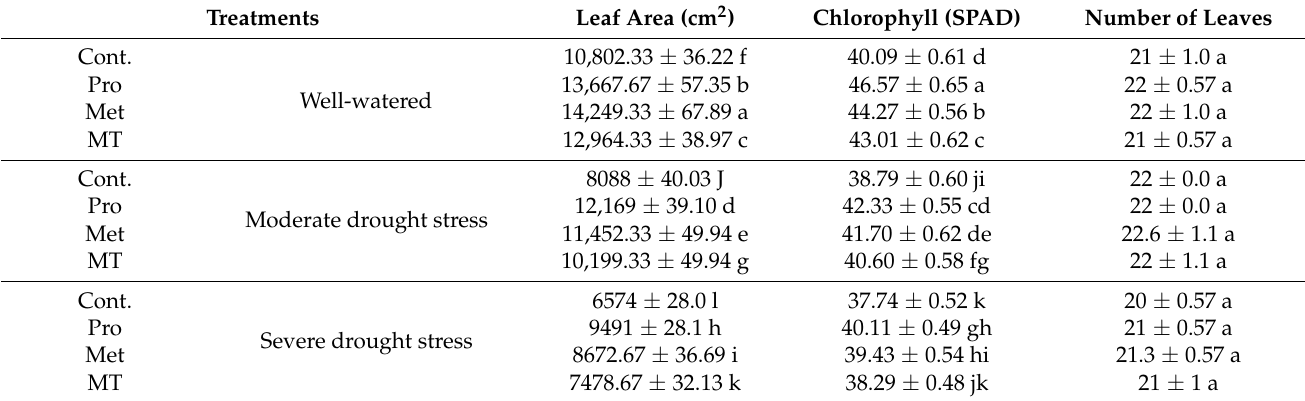
Table 1. Impact of interaction between treatments (proline, methionine, and melatonin) and water levels on leaf area, leaf chlorophyll content, and number of leaves of cauliflower plants grown under drought. ± Value indicates standard error (SE) of the means (n = 6). Means followed by different letters point to significant differences between the treatments at according to Tukey’s multiple range test ( p ≤